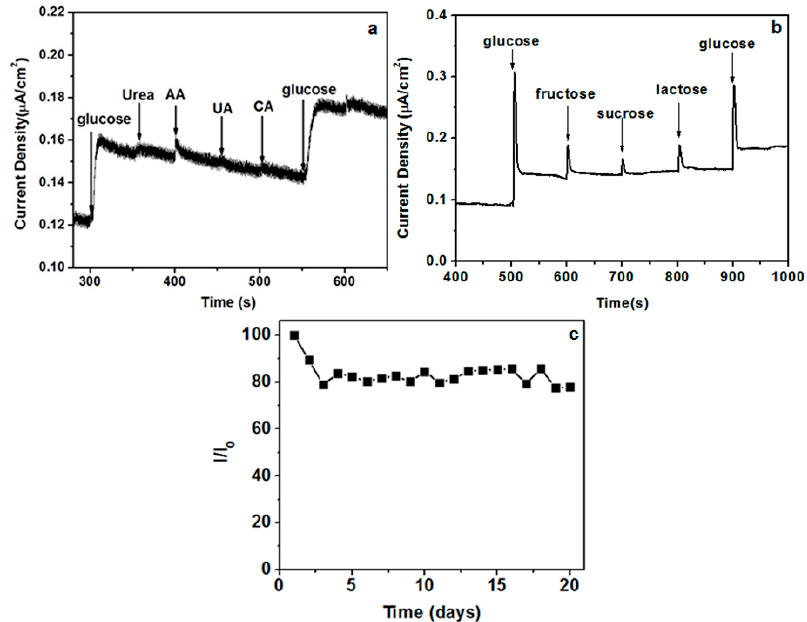
Figure 8. ( a ) Selectivity of CuO/CeO 2 /ITO electrode upon continuous adding 1 mM of glucose, urea, ascorbic acid (AA), uric acid (UA), citric acid (CA), and glucose at 0.4 V in 0.1 M PB solution; ( b ) Selectivity of CuO/CeO 2 /ITO electrode upon continuous adding 1 mM of glucose, fructose, sucrose, lactose, and glucose at 0.4 V in 0.1 M PB solution; ( c ) Stability of CuO/CeO 2 /ITO electrode at ambient conditions for 20 days using 5 mM glucose in 0.1 M PB solution at 0.4 V.